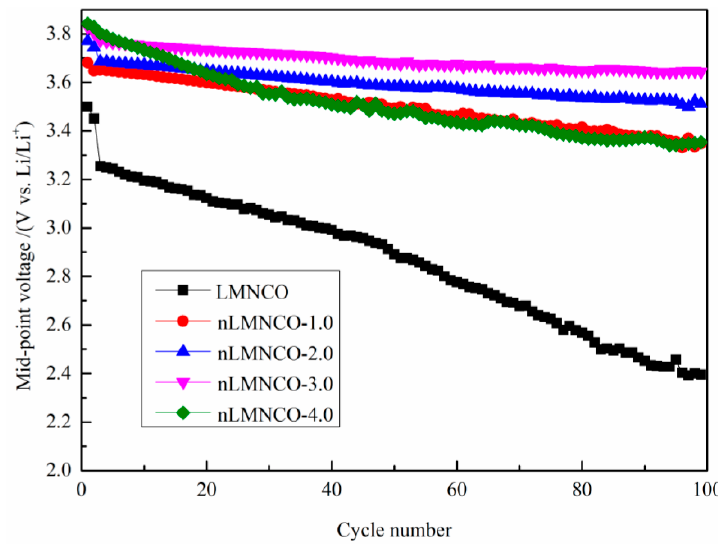
Figure 10. The median discharge voltage of cathode materials at 0.5 C.